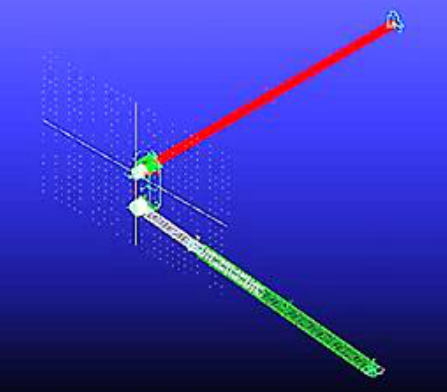
Figure 7. Model of experiment setup